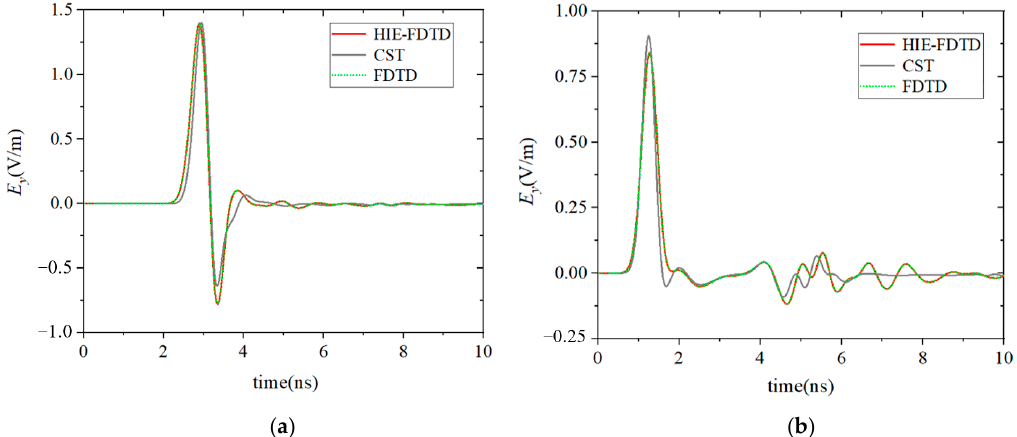
Figure 4. The calculated results of the FDTD method, HIE-FDTD method, and CST software. ( a ) Results of the observation point behind the plate. ( b ) Results of the observation point before the plate.